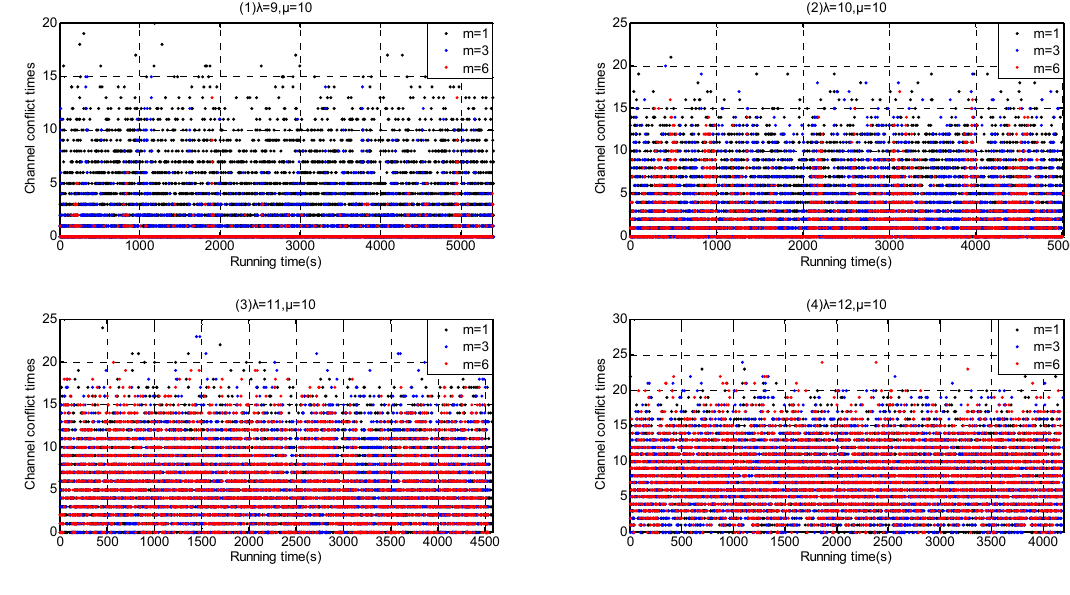
Figure 23. The times of channel conflicts in Service-dependent model.